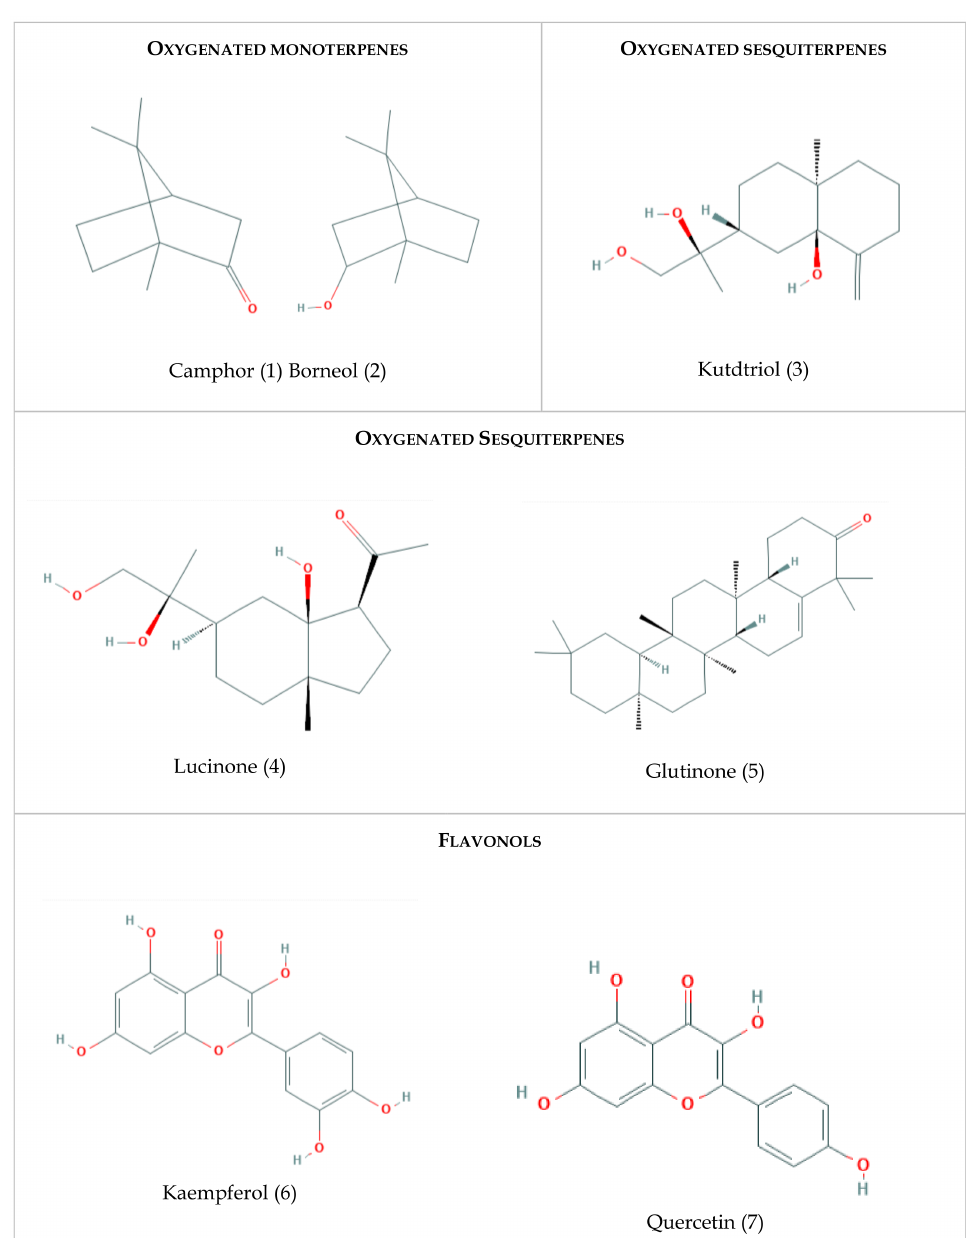
Figure 3. Chemical structure in a two-dimensional format of the main compounds present in Chiliadenus glutinosus . Images obtained from NCBI